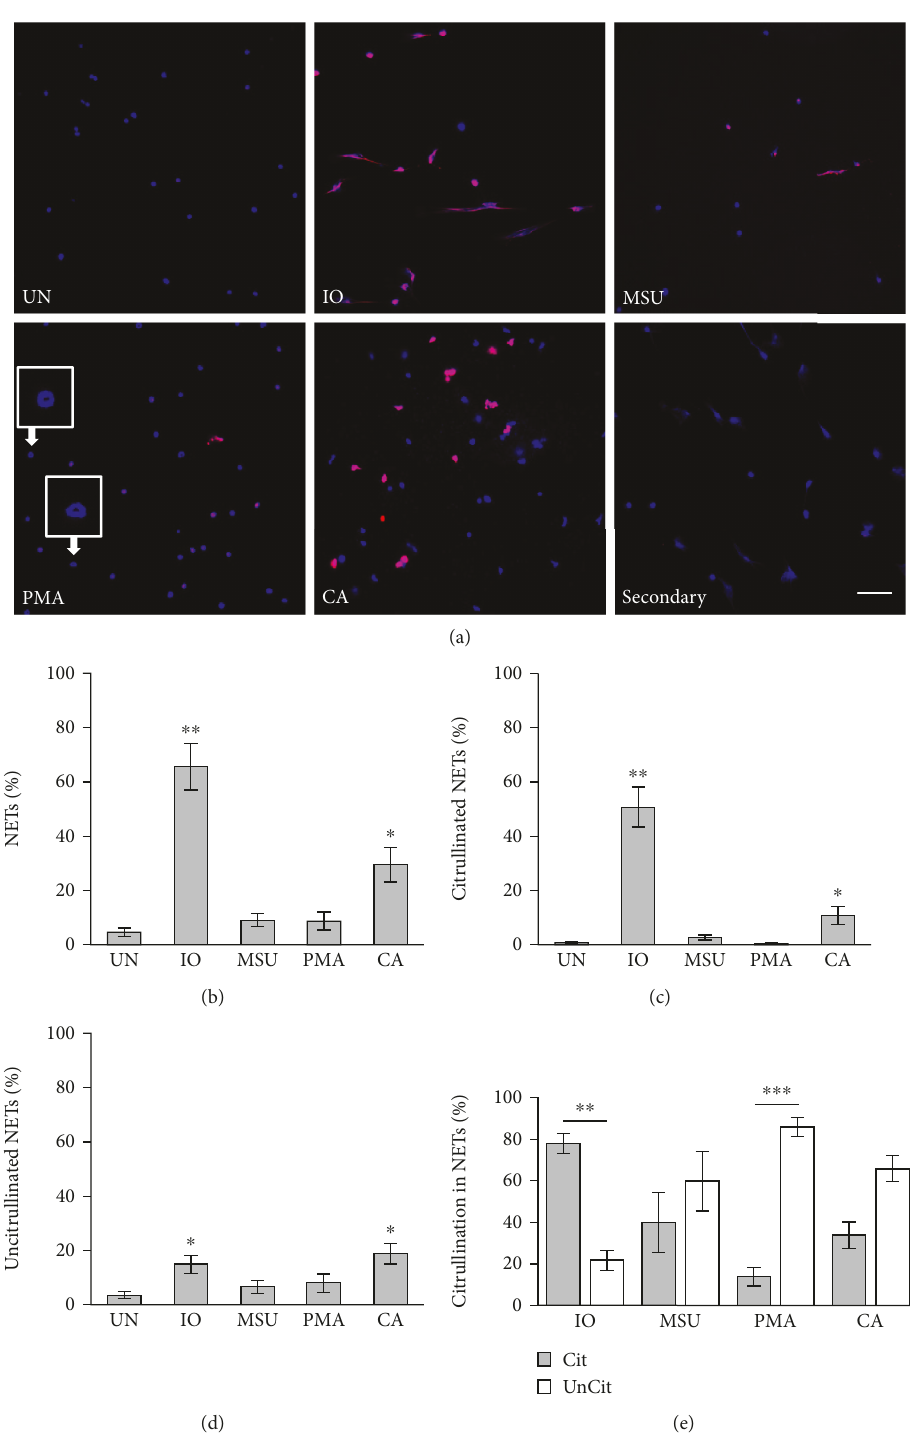
Figure 2: Induction of NETs in murine neutrophils. Murine neutrophils were left untreated (UN) or were treated with ionomycin (IO), MSU, PMA, and C. albicans (CA), fi xed, and stained with DAPI (blue) and anti-citrulline antibody (pink). Image labeled “ Secondary ” was created by stimulating neutrophils with ionomycin and staining without the F95 primary antibody and only the anti-mouse IgM-TRITC secondary antibody as a negative control. (a) Representative images at 400x, scalebar = 50 μ M . Enlarged insets demonstrate donut-like structures (doNETs). The number of neutrophils and NETs were quanti fi ed. Graphs depict the average and SEM for percent of neutrophils that formed total NETs (b), citrullinated NETs (c), and uncitrullinated NETs (d) for each condition with percent NETs for each stimulant compared to untreated. (e) The percent of citrullinated versus uncitrullinated NETs was compared for each stimulus with average and SEM graphed. For all panels: n = 6 ; ∗ p < 0 05 , ∗∗ p < 0 01 , and ∗∗∗ p < 0 001